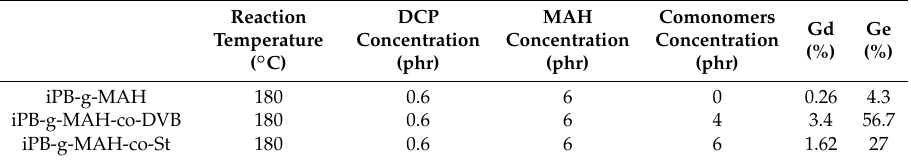
Table 1. The Gd and Ge of grafted iPBs with different comonomers.